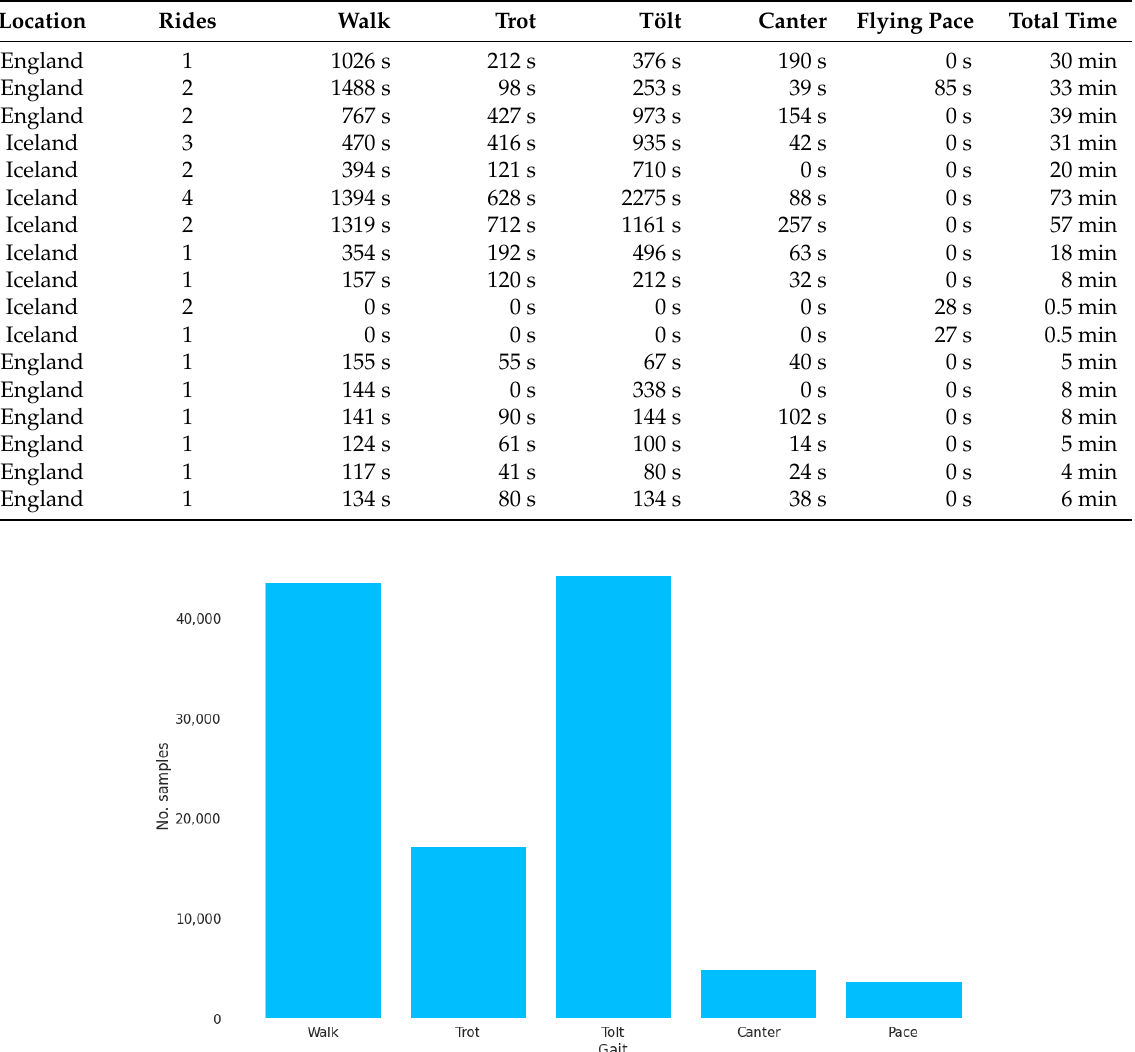
Table 3. Overview of the horses used for the study. The total time of labelled data sums up to 5.4 h. Note that only the horses in the 2nd, 10th, and 11th row are five-gaited.